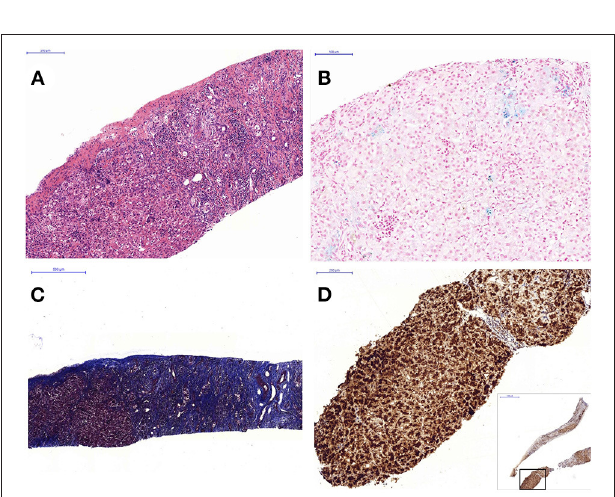
FIGURE 2 | Liver histopathology: (A) hematoxylin and eosin stain shows heavy inflammatory cell infiltration including eosinophils and residual hepatic hematopoiesis (100 × ), (B) iron stain shows grade 1 siderosis (blue-stained area) (200 × ), (C) Masson Trichrome stain shows severe fibrosis with cirrhotic change (40 × ). (D) Immunohistochemistry stain with C5b-9 antibody shows strongly positive cells (brownish stained area) involving 90% of the tissue (100 ×